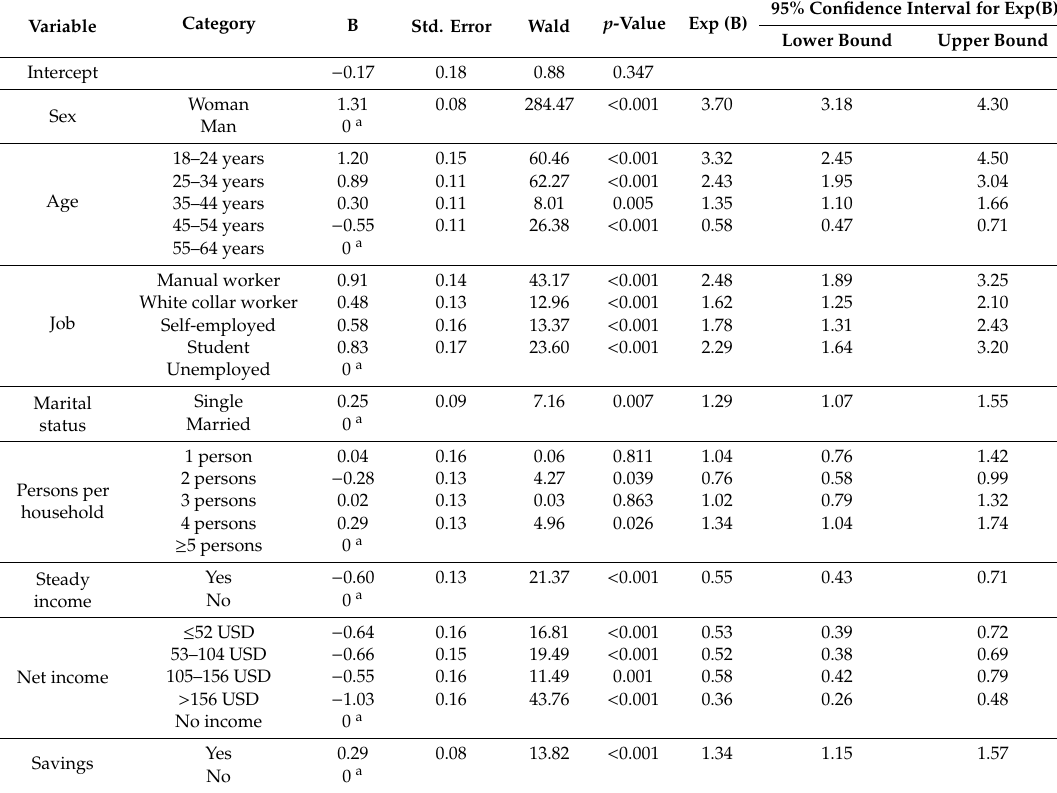
Table 4. Logistic model of body mass following WHO criteria with regard to selected demographic and socioeconomic characteristics of Wrocław residents ( n =